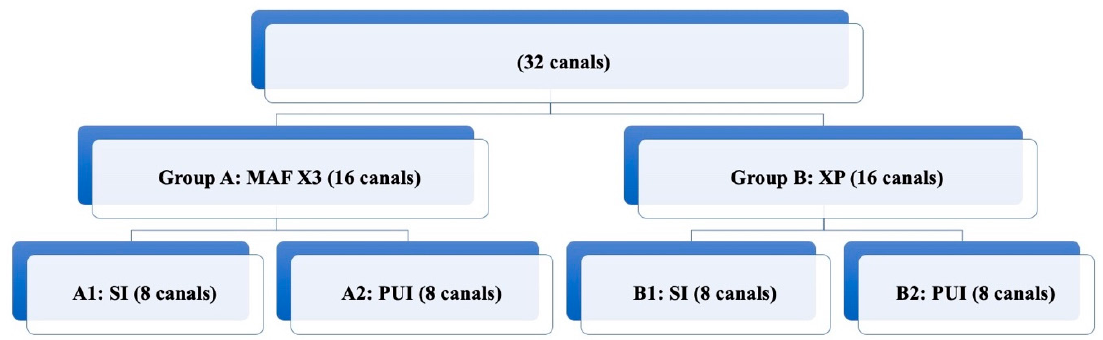
Figure 1. Distribution of different experimental groups according to the technique used for Ca(OH) 2